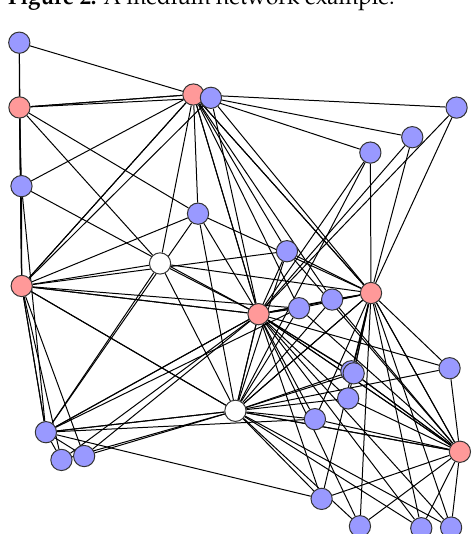
Figure 3. A large network